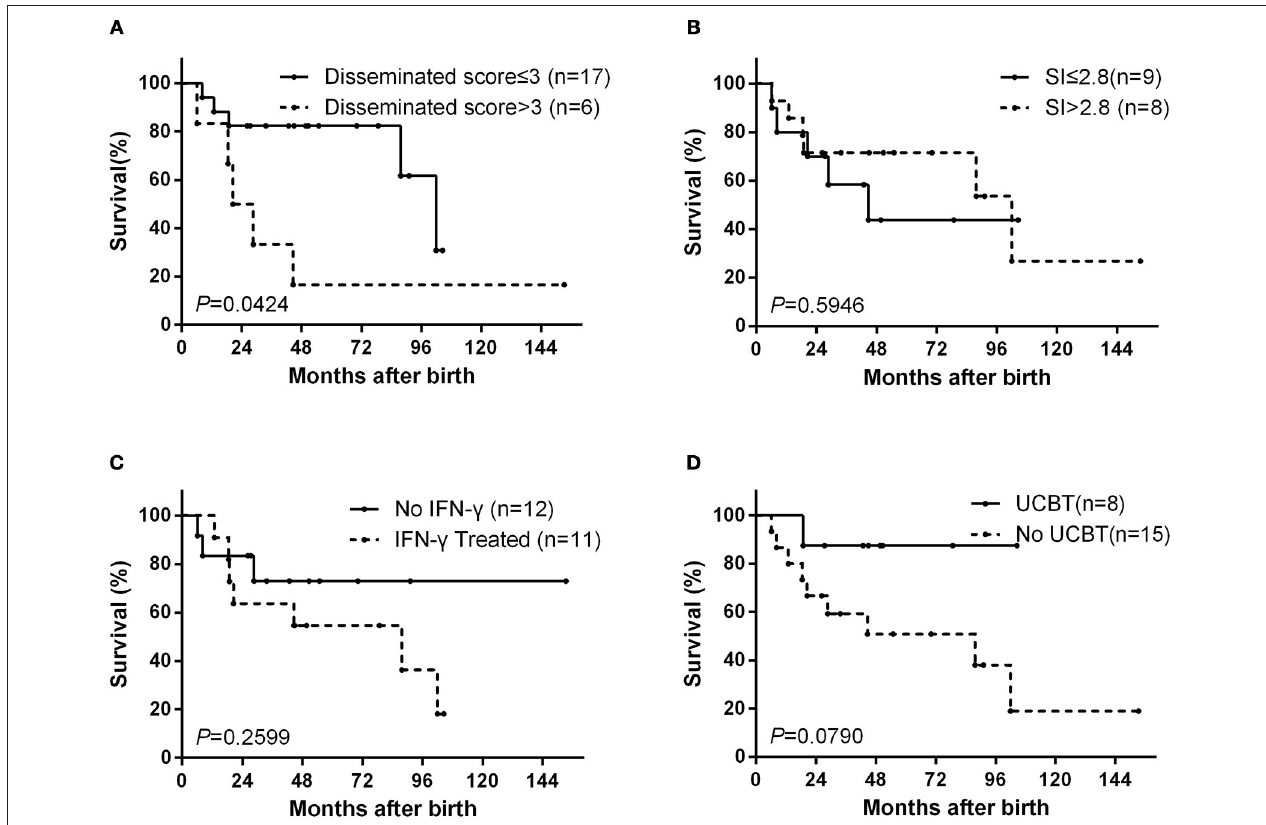
FIGURE 2 | Kaplan–Meier survival curves from the date ot birth. The curves are shown for (A) according to dissemination score, (B) according to the dihydrorhodamine assay stimulation index (SI), (C) according to interferon (IFN)- γ treatment status, and (D) according to umbilical cord blood transplantation (UCBT)